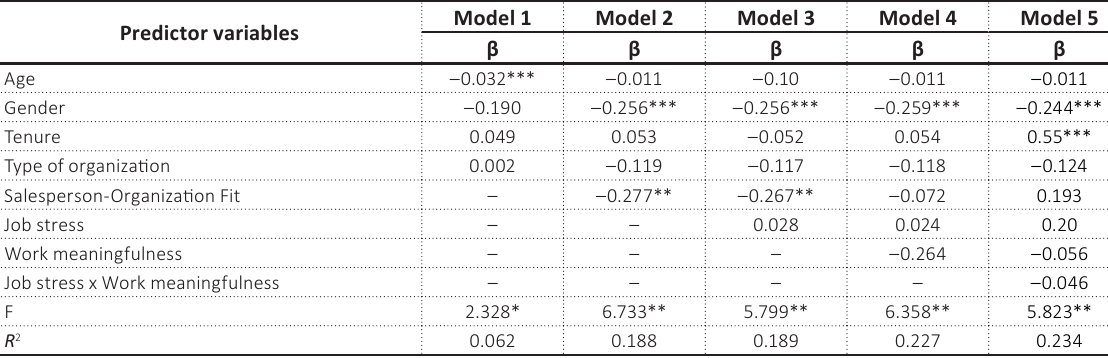
Table 2. Regression results predicting interpersonal deviance